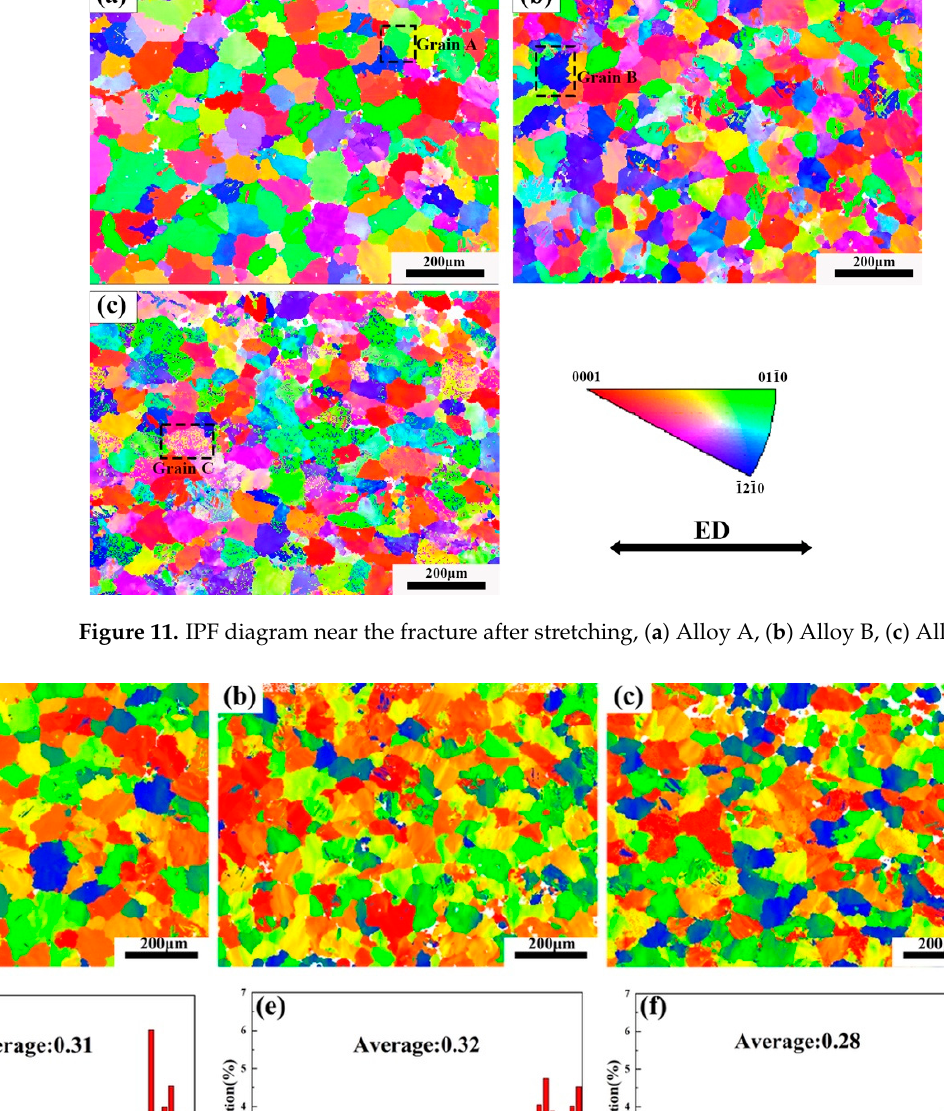
Figure 13. Select Grain A, B and C without twins and the second phase from Alloy A, B and C in Figure 11. IPF image and Kernel average misorientation (KAM) maps of grans: ( a ) Grain A, ( b ) Grain B, ( c ) Grain C. Figure 14 shows the KAM and grain boundary images near the fracture of the three tensile samples. Figure 14a–c shows the KAM images. Alloy A exhibits the lowest KAM value (0.7), indicating the lowest local misorientation [37]. The KAM value of Alloy B is much higher than that of Alloy A, which is not conducive to improving ductility in theory. However, the experimental results are contrary to it. This is due to the α‐ Mg/LPSO inter ‐ face being an effective barrier to hinder the movement of dislocations, and a lot of dislo ‐ cations accumulate inside the grains, which slows down the failure process of Alloy B grain boundaries due to stress concentration and improves the UTS and ductility of Alloy B. As shown in Table 2, compared with Alloy B, Alloy C exhibits a lower KAM value (1.13) and higher LAGBs (61.7%), which is beneficial to the increase in ductility [38]. Figure 15 shows the SF profiles of the pyramidal <c + a> slip for three tensile samples. The average SF value of pyramidal slip in Alloy C is higher than that in Alloy B, indicating that more pyramidal <c + a> slip is activated in Alloy C, non ‐ basal slip can promote more uniform deformation of grains and reduce stress concentration, which is also conducive to the in ‐ crease in ductility [39 ‐ 41].